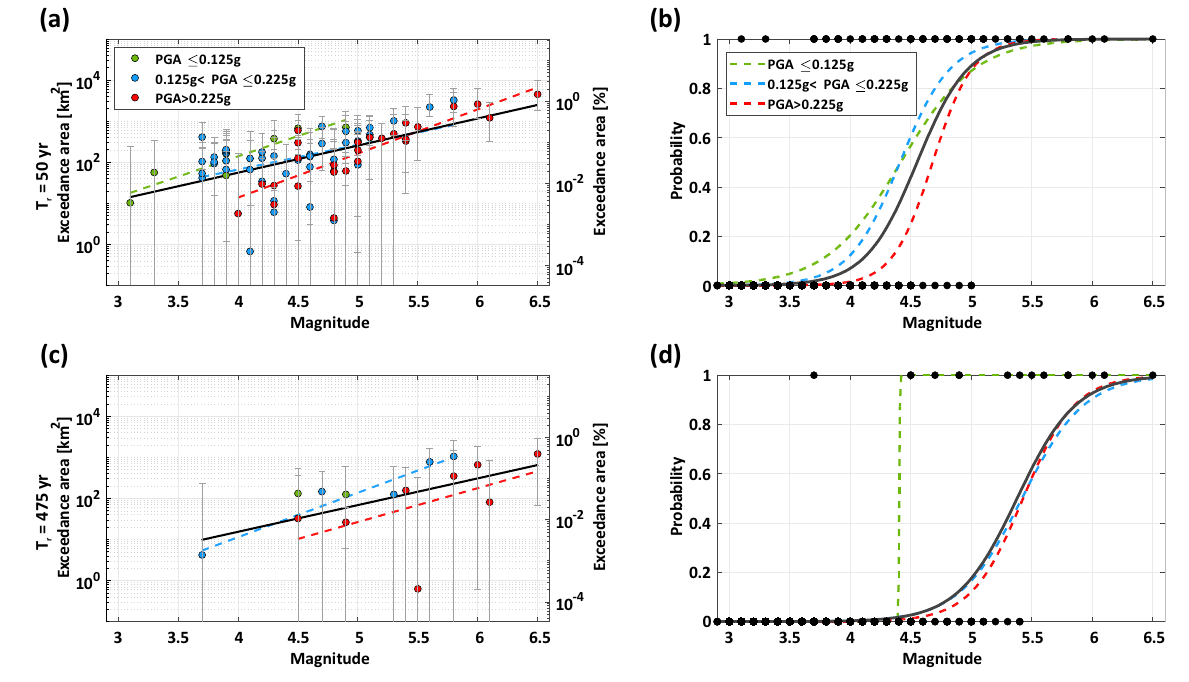
Figure 3. ( a ) PGA exceedance area of the design action with 50 years return period, in terms of km 2 and of fraction of the Italian territory, as a function of event magnitude; ( b ) logistic regression and data of events exceeding the 50 years return period PGA; ( c ) and ( d ) refer to 475 years return period.